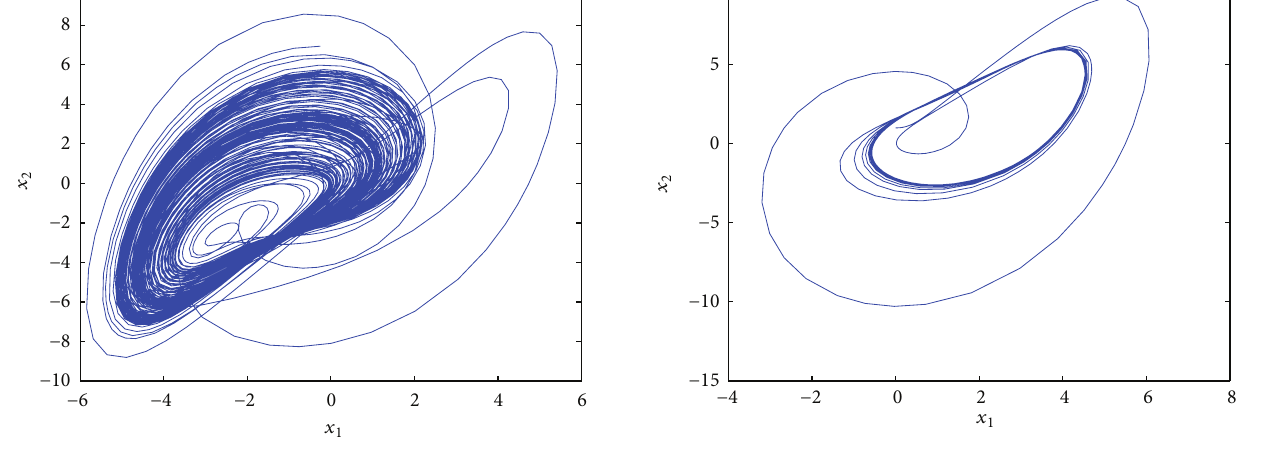
Figure 5: Left half attractor (𝑢 = −2.9) .